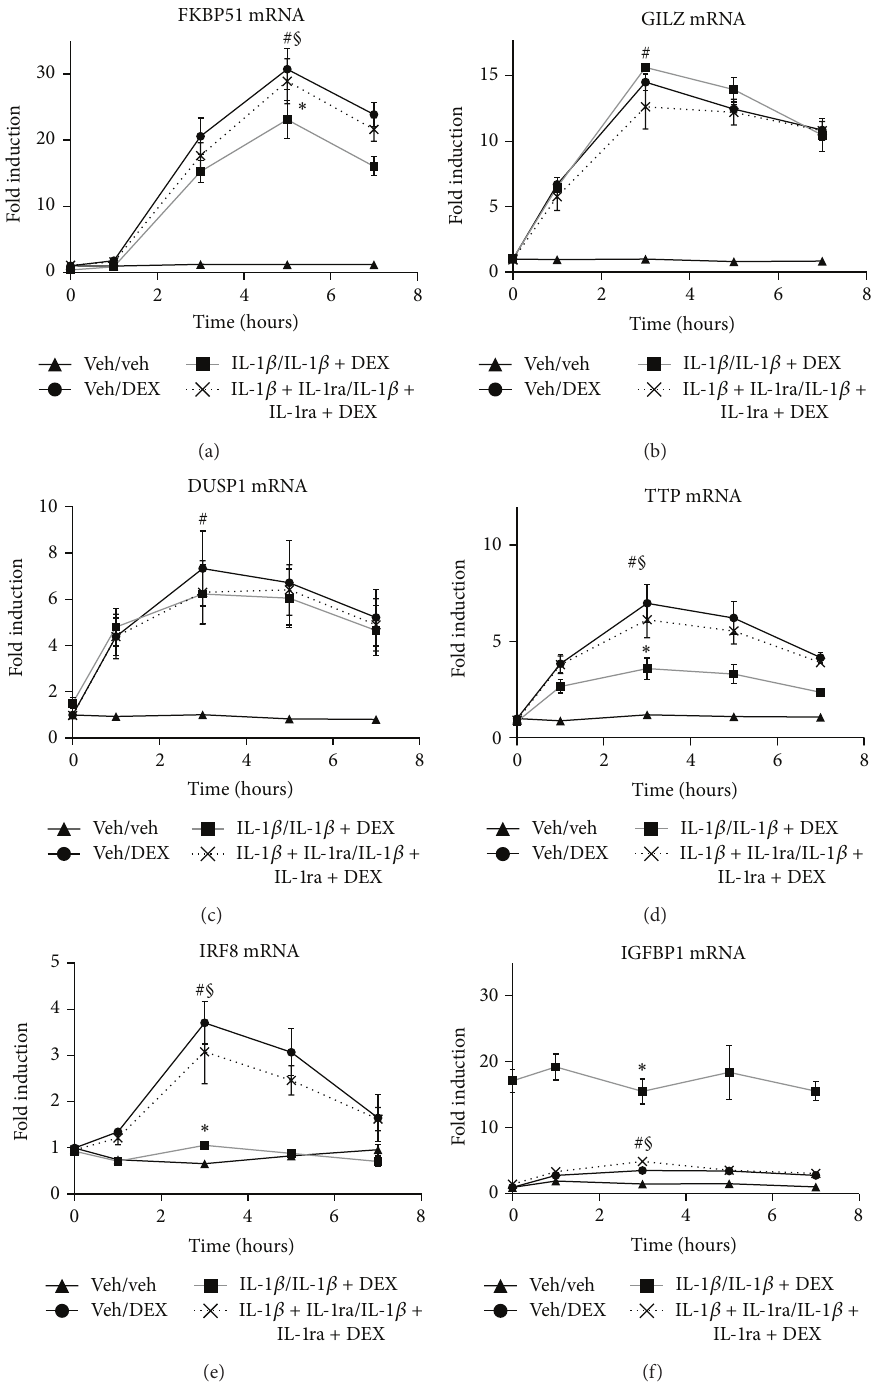
Figure 5: Sustained incubation with IL-1 𝛽 promotes a split responsiveness of GC-induced anti-inflammatory genes: selective reduction in FKBP1, IRF8, and TTP, superinduction of IGFBP1 and unchanged DUSP1 and GILZ mRNA expression. Cells were cultured in complete medium (veh/veh, 󳵳 , solid line), pretreated 16h in vehicle, then treated with 10 −8 M DEX alone for the indicated times (veh/DEX, e , solid line), subjected to sustained IL-1 𝛽 conditions (16h 5 ng/mL IL-1 𝛽 /5ng/mL IL-1 𝛽 + 10 −8 M DEX for the indicated times, ◼ , solid grey line), or treated under sustained IL-1 𝛽 conditions in the presence of IL-1ra (16h 5 ng/mL IL-1 𝛽 + IL-1ra/5ng/mL IL-1 𝛽 + IL-1ra + 10 −8 M DEX for the indicated times, × , dashed line). After the indicated treatments, the cells were collected and mRNA extracted and quantitated by real-time RT-PCR. The time-course curves represent the mean ± SEM fold-changes in the expression of FKBP51 (a), GILZ (b), DUSP1 (c), TTP (d), IRF8 (e), and IGFBP1 (f) mRNAs, for each culture condition compared to veh/veh-treated cells at 0h ( 𝑛 = 5 ). # 𝑃 < 0.05 , veh/DEX-treated versus veh/veh-treated cells. ∗ 𝑃 < 0.05 , sustained IL-1 𝛽 conditions versus DEX alone-treated cells. § 𝑃 < 0.05 , differences between cells under sustained IL-1 𝛽 conditions in the presence or absence of